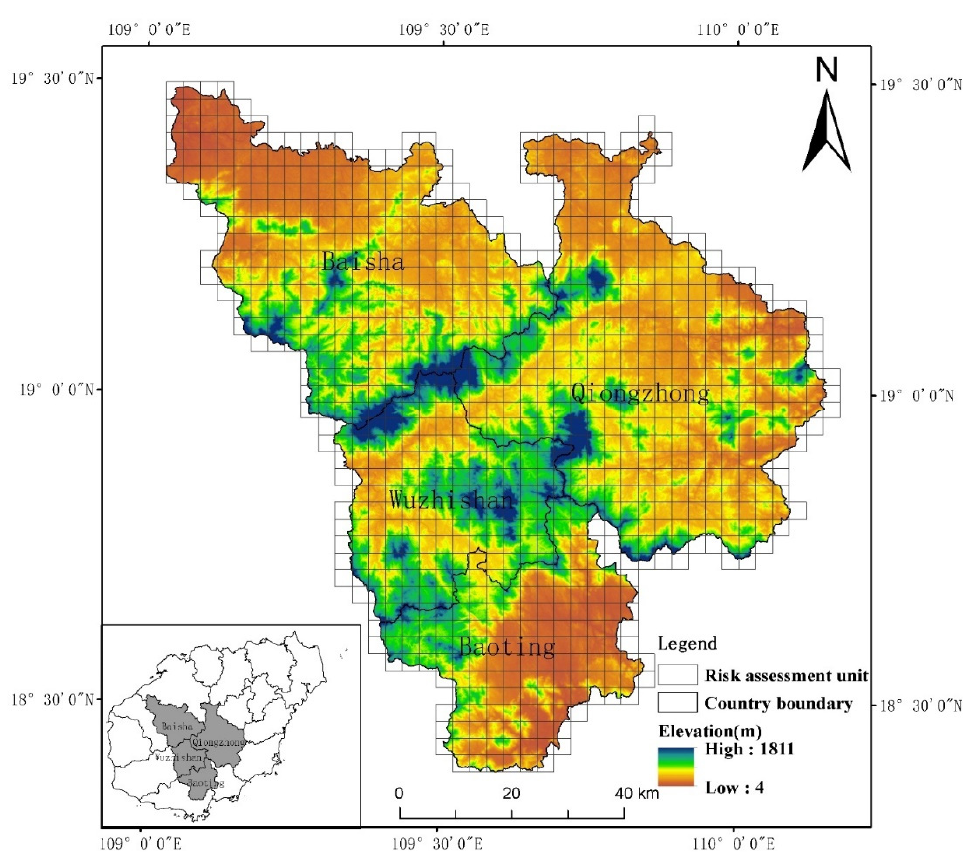
Figure 1. The location of the central mountainous area and risk assessment unit division.